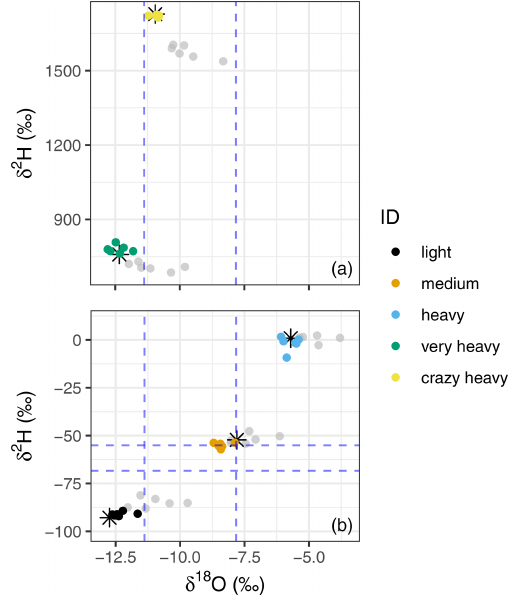
Figure 7. Dual isotope plots of the raw mean (grey dots) and cor- rected and calibrated mean (coloured dots) of the lab trial storage data, corrected for the “storage effect” and calibrated using the lin- ear regression models of each storage time. Sources are depicted by colour and the liquid true value is indicated by black stars. Panel (a) shows the data of the two sources enriched in 2 H (“very heavy” and “crazy heavy”, for the calibration we also used the “heavy” source; however, we refrain from plotting it again here as it un- necessarily enlarges the figure), whereas panel (b) depicts the three natural abundance sources (i.e. “light”, “medium”, and “heavy”). The dashed blue lines show the range of the background atmosphere during a few days of the lab trial. They are indicated here in support of the argument of isotopic non-drifting towards the room air (see text).